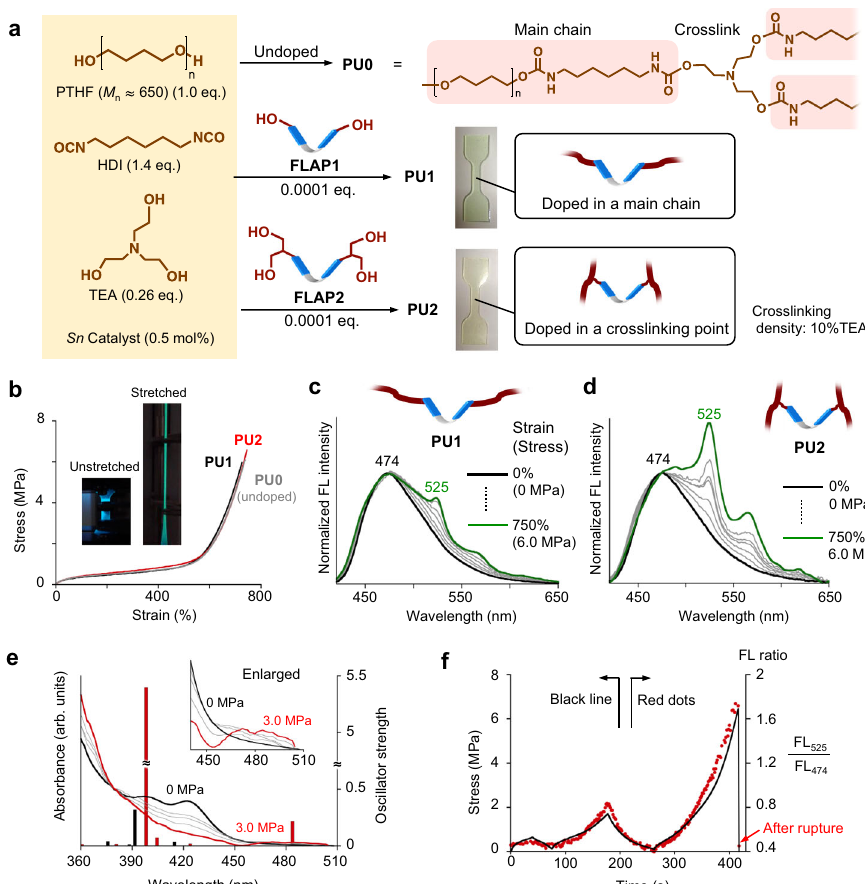
Fig. 4 Controlled chemical doping of the force probe in crosslinked polyurethanes and the mechanical/optical properties under the uniaxial stretching conditions. a Doping of FLAP1 and FLAP2 in crosslinked polyurethanes, PU1 and PU2 , respectively. PTHF: poly(tetrahydrofuran); HDI: hexamethylenediisocyanate; TEA: triethanolamine; Sn catalyst: dibutyltin dilaurate. The crosslinking density can be tuned by the molar ratio of TEA to the other monomer components. b Engineering stress – strain curves of rubbery polyurethanes, PU1 , PU2 and undoped PU0 with a crosslinking density of 10% TEA. Inset images: unstretched and stretched fl uorescent specimens of PU2 under UV light. c , d FL spectral changes during the tensile testing of PU1 and PU2 . FL intensity was normalized at 474nm. Excitation wavelength: 365 nm. e An absorption spectral change of PU2 by stretching the specimen. Oscillator strengths were calculated at the unstretched and fully stretched geometries (Supplementary Tables 12 and 13) at the TD PBE0/6-31 + G(d) level. f Real- time and reversible FL response during the loading – unloading cycle of PU2 . Time-dependent stress (black line) and FL ratio plots (red